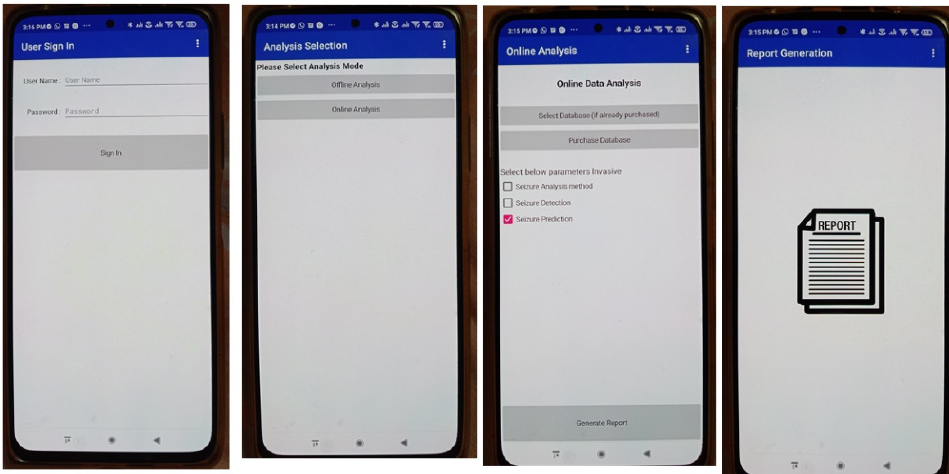
Figure 6. Smart phone application interface with raspberry-pi 4 and Amazon EC2.